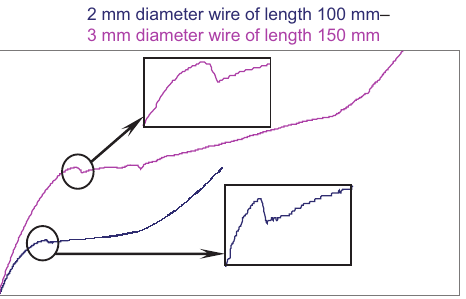
Figure 4 Quasi-plastic material response showing relation between nucleation and transformation load behavior at a displacement rate of 2